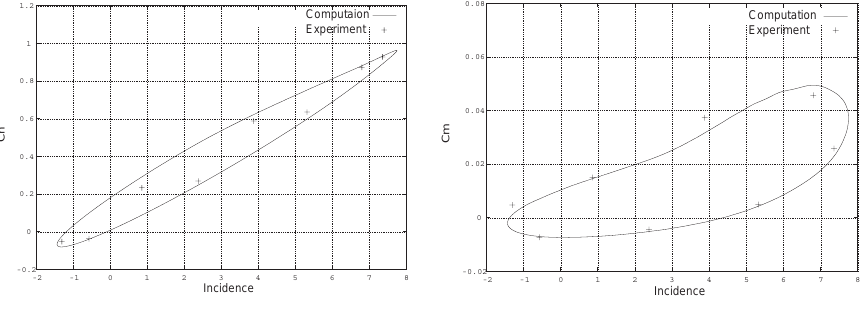
Fig.1 Comparison of computed and experiment force and moment (CT2).